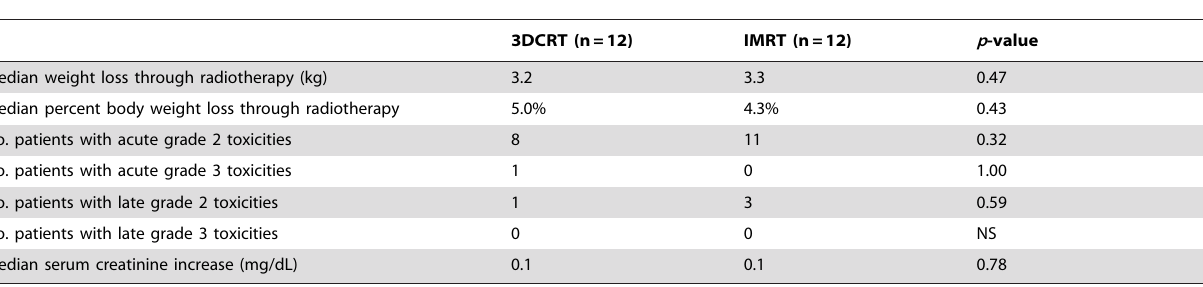
Table 3. Acute Radiation